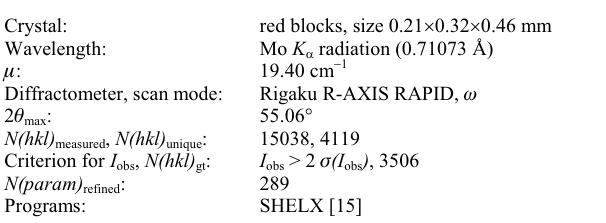
Table 1. Data collection and handling.